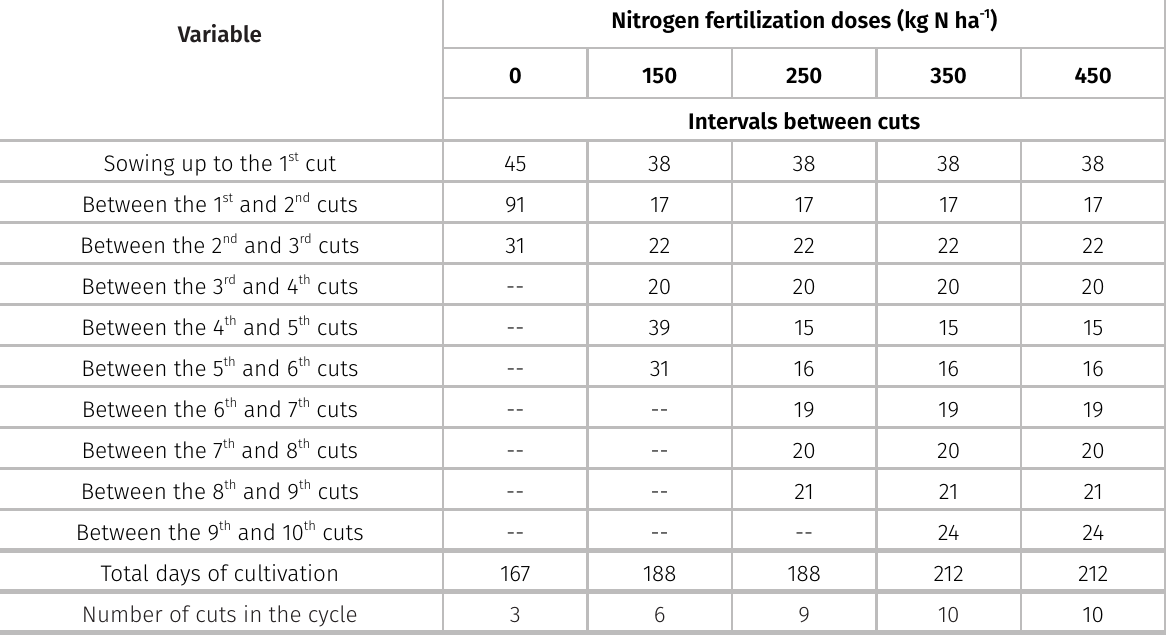
Table III. Intervals between cuts, days of dual-purpose wheat pasture BRS Tarumã cultivation managed with different nitrogen doses, and number of cuts per